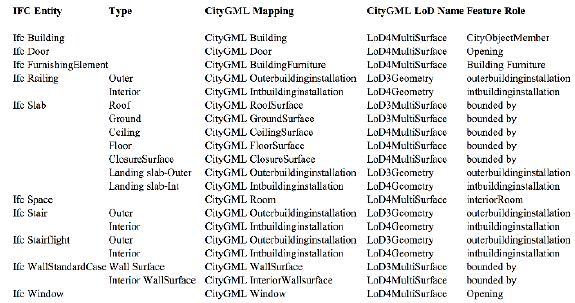
Figure 3: Semantic mapping from IFC to CityGML LoD